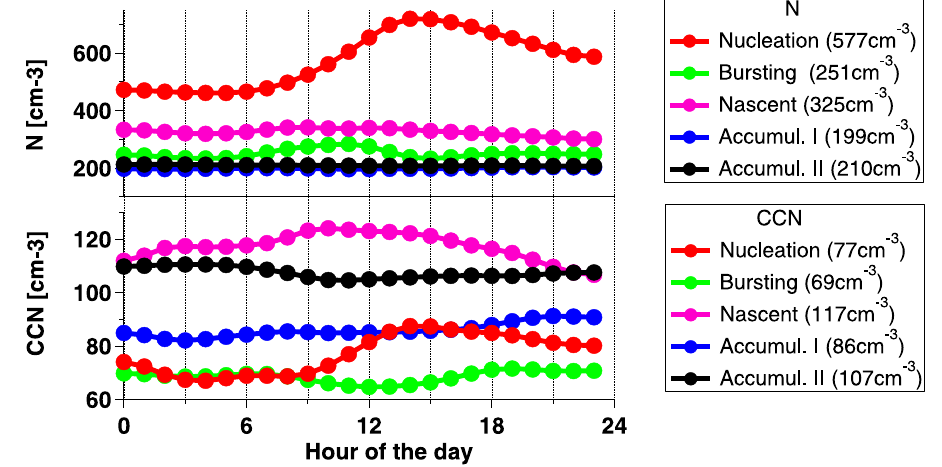
Figure 5. Diurnal profiles of N and CCN categorised according to aerosol size resolved particle number distribution clustering. In brackets, average particle number and CCN concentrations for each aerosol